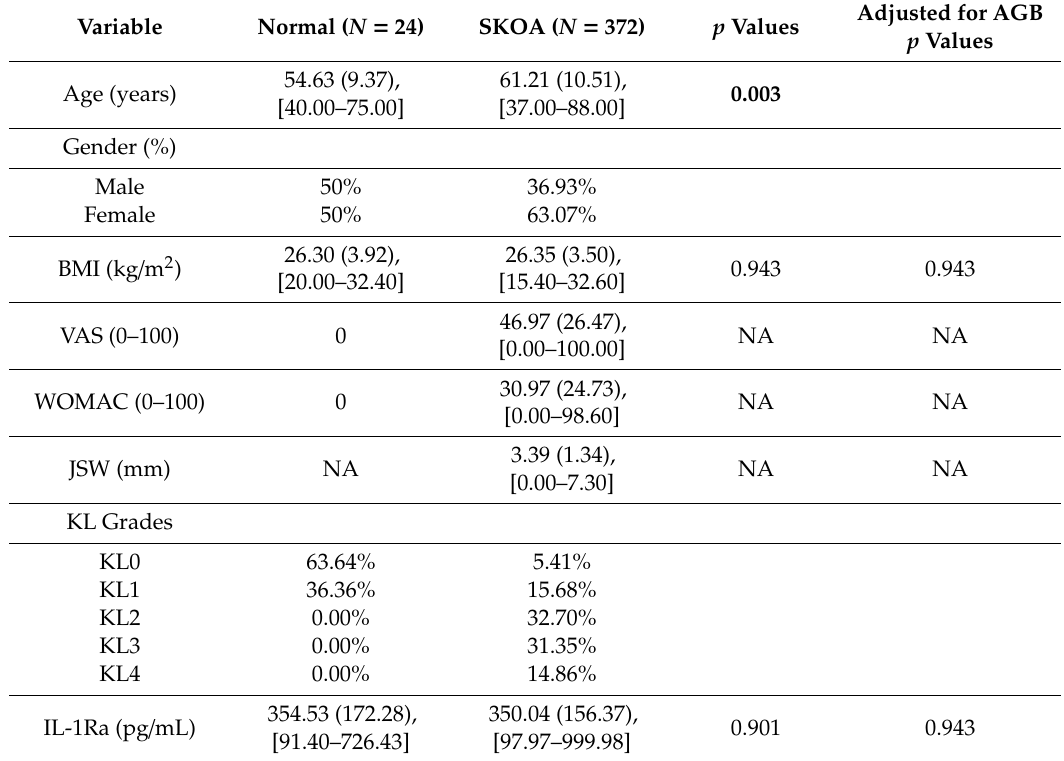
Table 1. Baseline demographics and biomarker levels of the New York University (NYU) cohort of normal subjects and symptomatic knee osteoarthritis (SKOA)